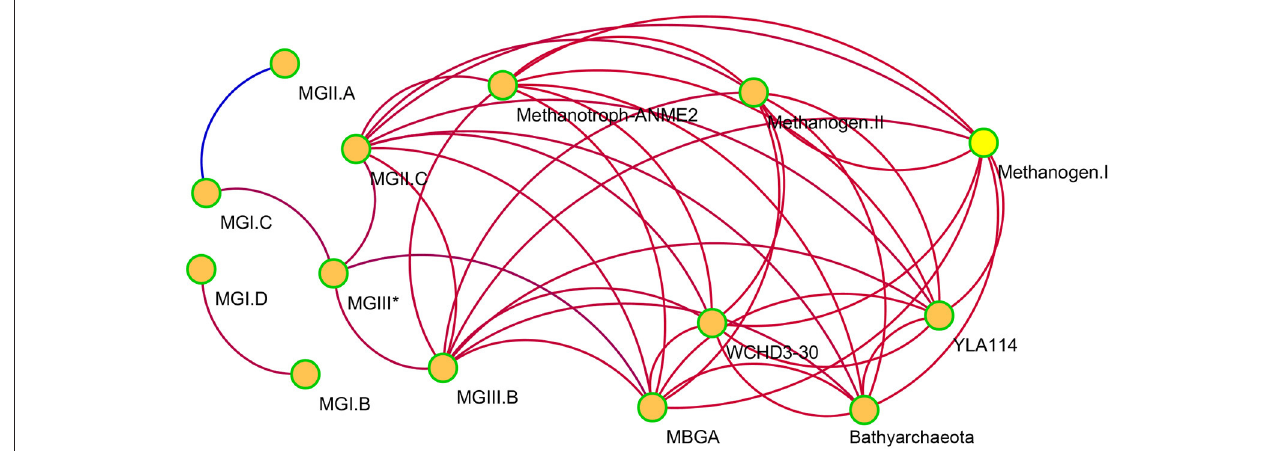
FIGURE 6 | Co-occurrence network of archaeal groups based on correlation analysis. A connection stands for a strong (Spearman’s r > 0.6 or < − 0.6) and significant ( P -value < 0.01) correlation. The red and blue lines indicate positive and negative correlation, respectively.